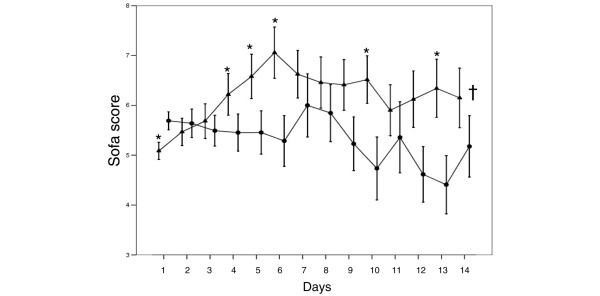
Time course of sequential organ failure assessment (SOFA) score during the first two weeks in the intensive care unit (ICU) in patients who were readmitted to the ICU. Closed circles = scores during the initial stay; closed triangle = score during the first readmission. *p < 0.05 compared with initial stay (Mann Whitney U test); †p < 0.05 over time (Friedmann test).